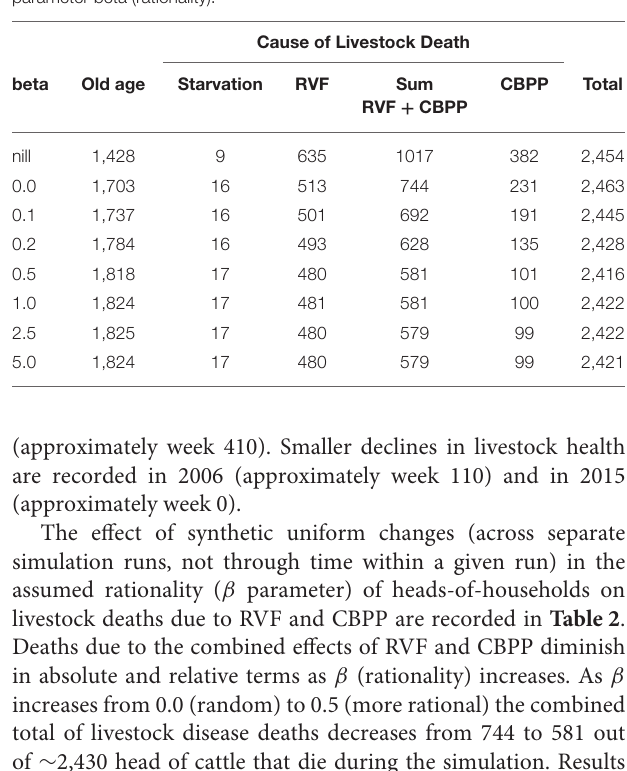
TABLE 2 | Causes of livestock death resulting under different assumed values for parameter beta